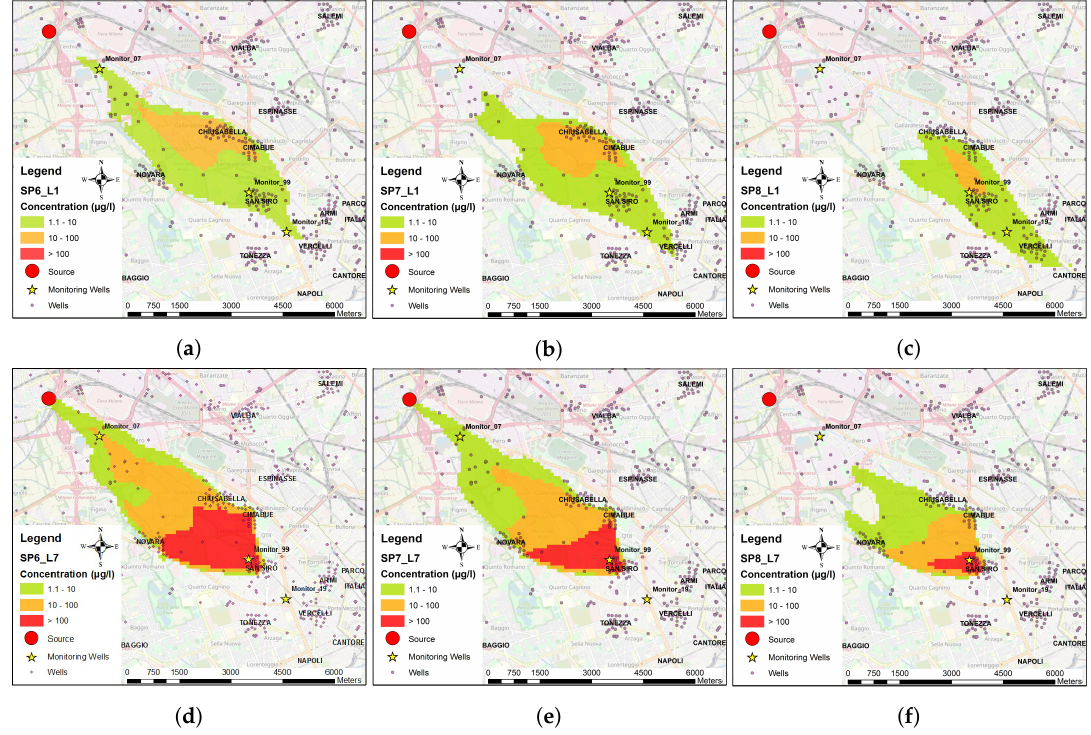
Figure 9. The rows represent the simulated plume for the same layer while the columns represent the same year (2021, 2027, and 2040, respectively). Figures ( a – c ) are relative to layer 1 (Aquifer A, shallow), while figures ( d – f ) represent layer 7 (Aquifer B,